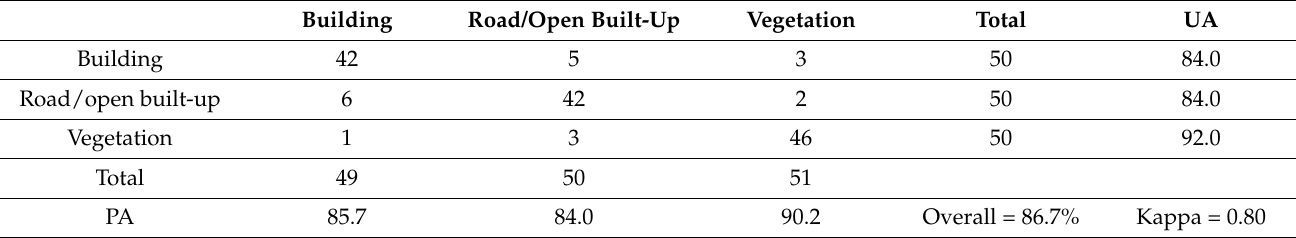
Table 2. Error matrix for OBIA image classification was generated using reference data derived from visual interpretation of WorldView-2 image and the Google Earth’s very high-resolution imagery archive. A total of 150 OBIA-derived polygons were randomly selected for the accuracy assessment. UA and PA denote user’s and producer’s accuracy,